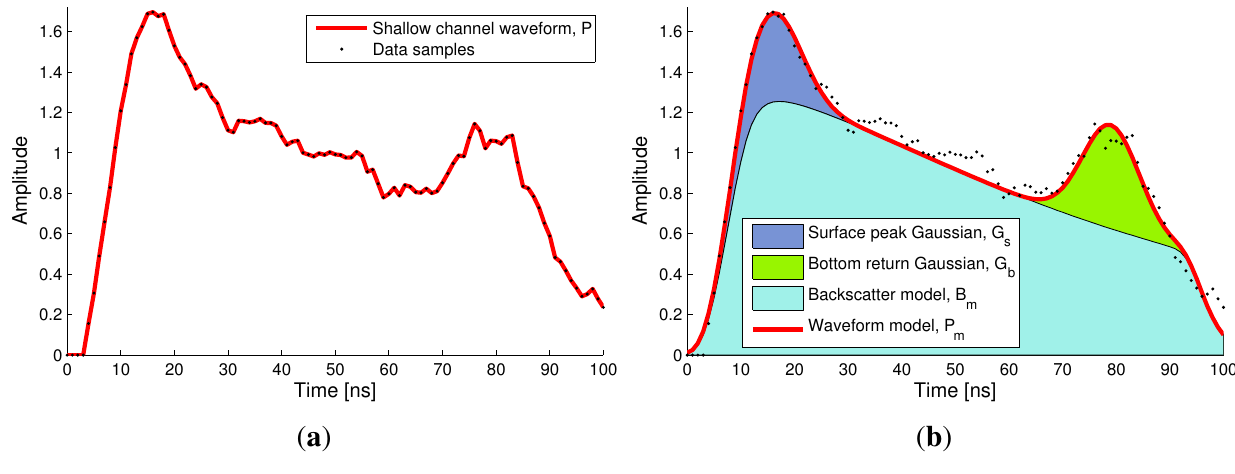
Figure 4. ( a ) Bathymetric LiDAR waveform from the deep region. ( b ) Waveform modeling components.